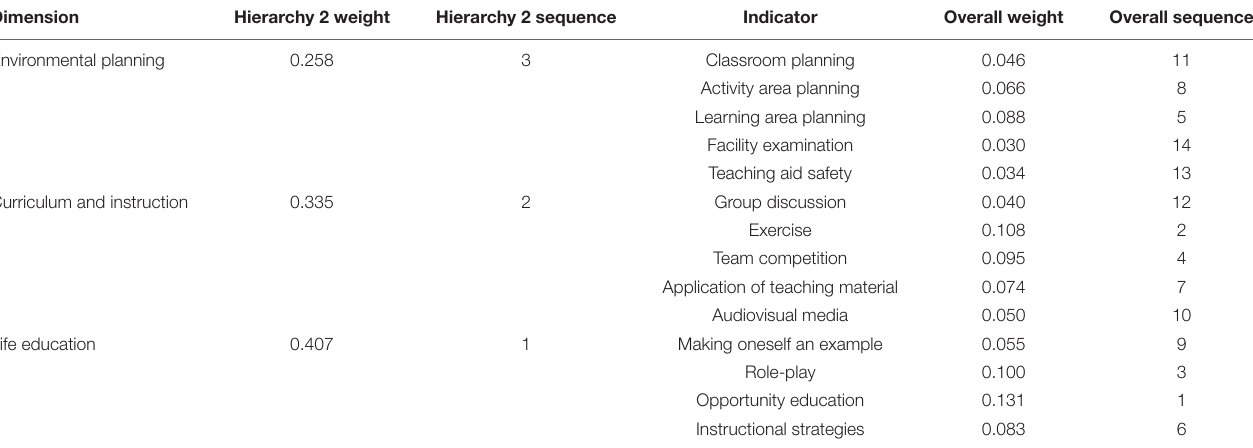
TABLE 1 | Overall weight of factors in risk awareness education in universities in China. Dimension Hierarchy 2 weight Hierarchy 2